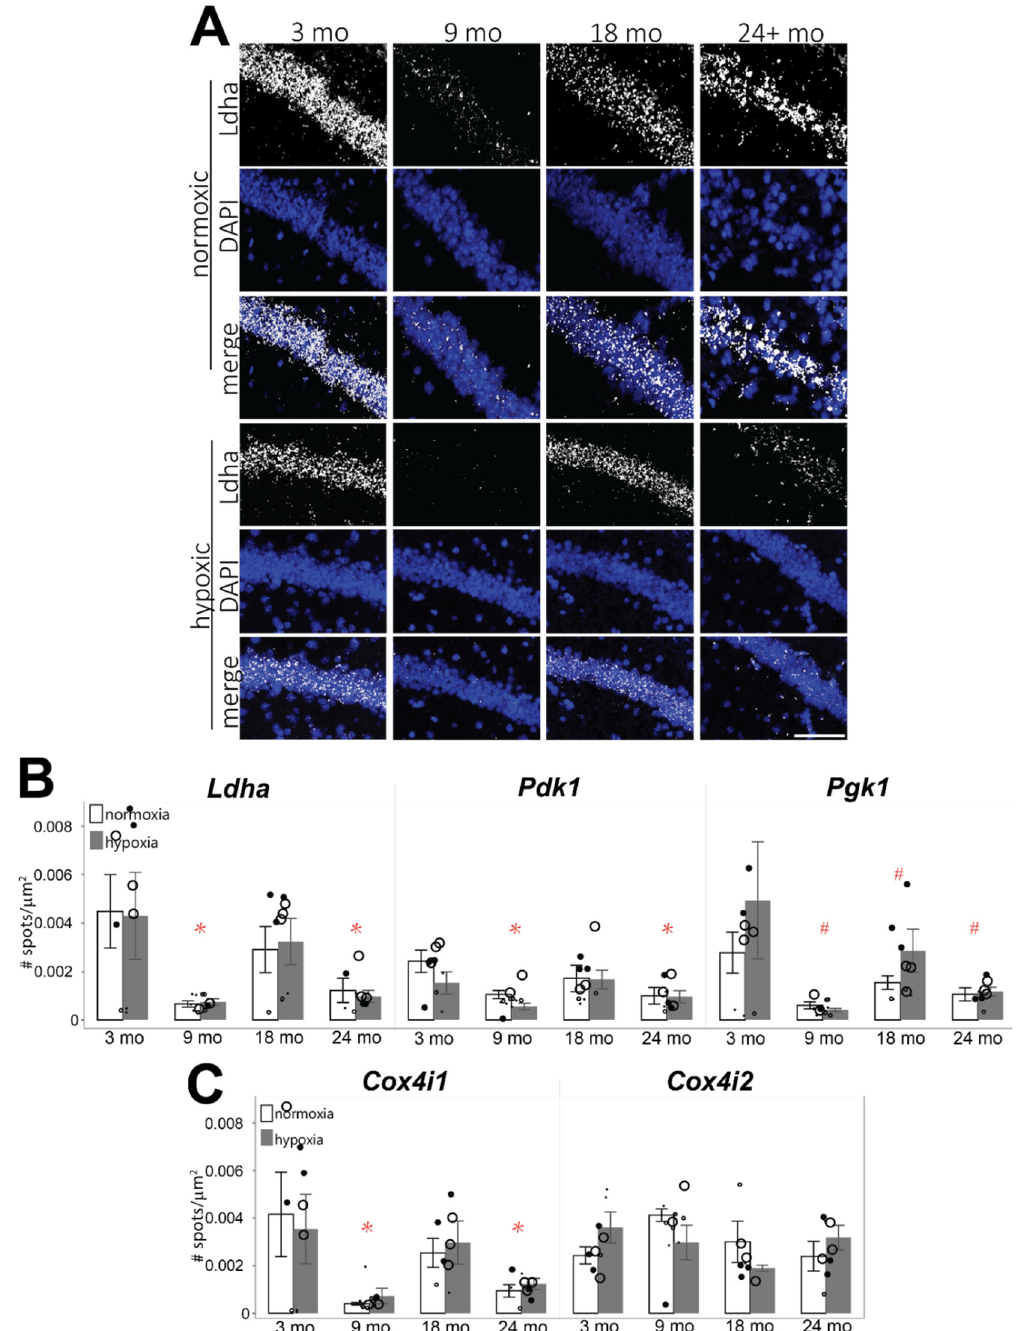
Figure 6. mRNA levels of metabolic genes transcribed by HIF- α in the hippocampus of different aged mice exposed to room air or hypoxia. ( A ) Representative images of Ldha mRNA labeled by fISH in the CA1 region of the hippocampus. ( B ) Ldha, Pgk1, and Pdk1 mRNA levels counted in the hippocampus of 3 mo, 9 mo, 18 mo, and 24 mo mice exposed to room air or hypoxia. ( C ) Cox4i1 and Cox4i2 mRNA levels counted in the hippocampus of 3 mo, 9 mo, 18 mo, and 24 mo mice exposed to room air or hypoxia. Results are reported as the mean number of spots counted per area ( μ m 2 ). Scale bar = 100 um; p ≤ 0.05; * = compared to 3-mo normoxic control; # = interaction with hypoxia; small dots = female mice; large dots = male mice; normoxic = open circles); 3% oxygen for 3 h = filled circles.